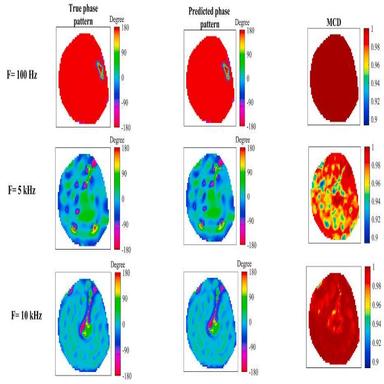
ML model prediction results of the TM phase vibration pattern. The results are presented at three frequencies: 100 Hz (low), 5 kHz (middle), and 10 kHz (high). The left and middle columns show the true and predicted vibration phase patterns for one of the random test sets. The results show that at all these three frequencies, the predicted phase pattern is very close to the true pattern. The rightmost column represents the values of MCD at these frequencies. The values of MCD presented in this column are ca